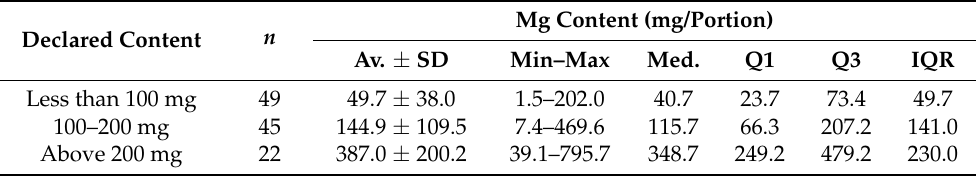
Table 1. Magnesium content (mg/portion) in food supplements depending on the declared magne-